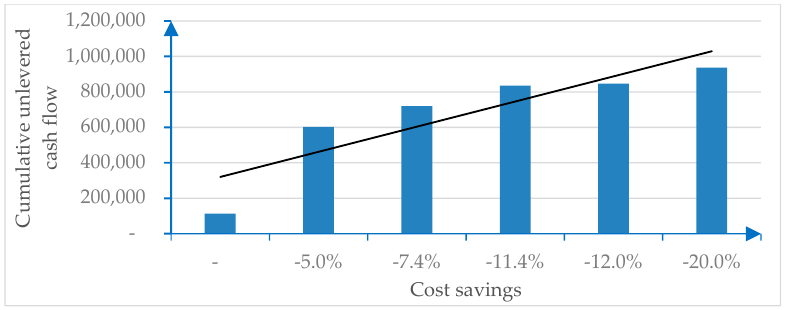
Figure 2. Cost savings due to digitalization.